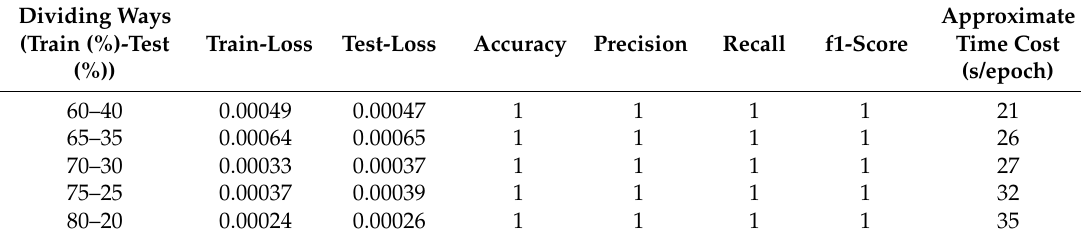
Table 7. The different dividing ways of the hold-out method.